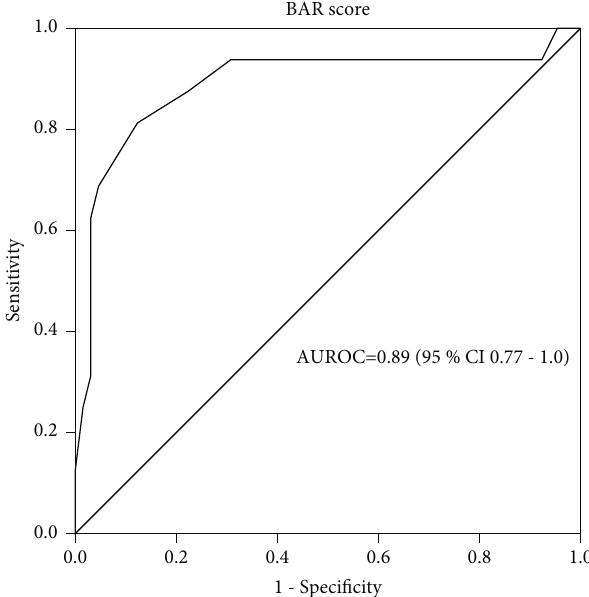
Figure 1: Receiver operating characteristic curve for the BAR score in predicting post-transplant 3-month survival. BAR, balance of risk; AUROC, area under the receiver operating characteristic curve.